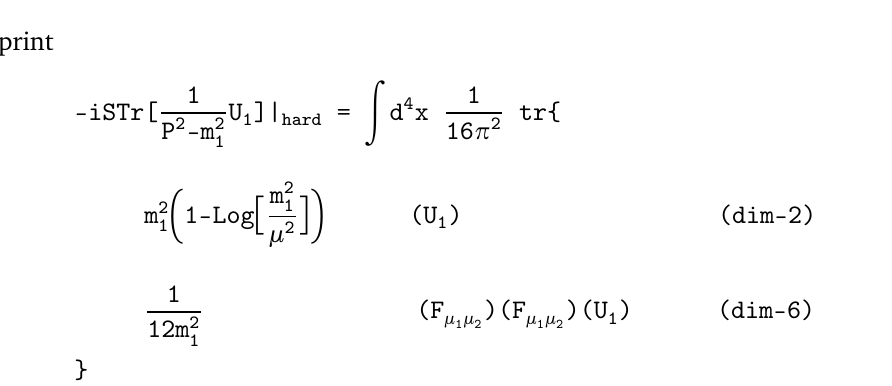
TableForm , together with the input supertrace. Again for the example in Eq.